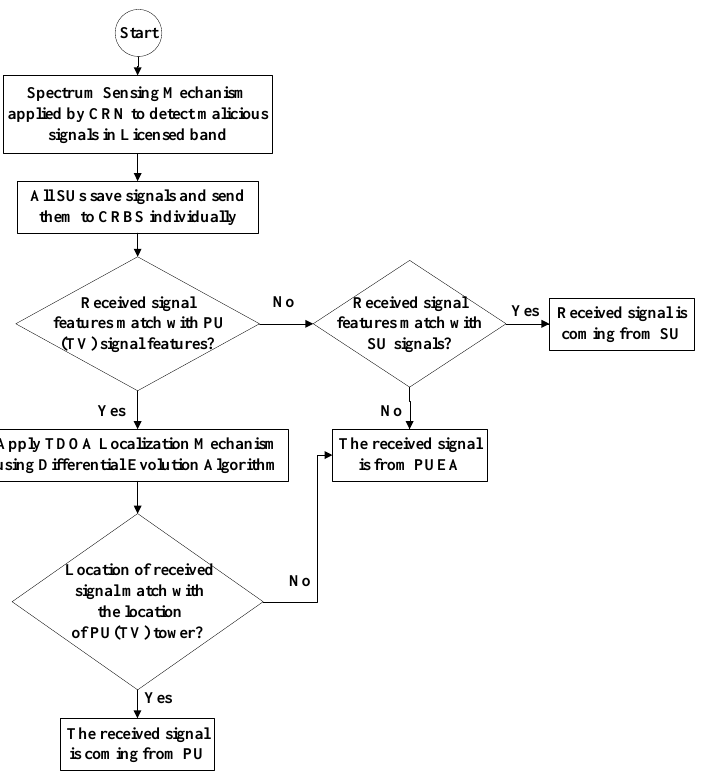
Figure 2. Workflow of TDOA based localization technique using Differential Evolution .